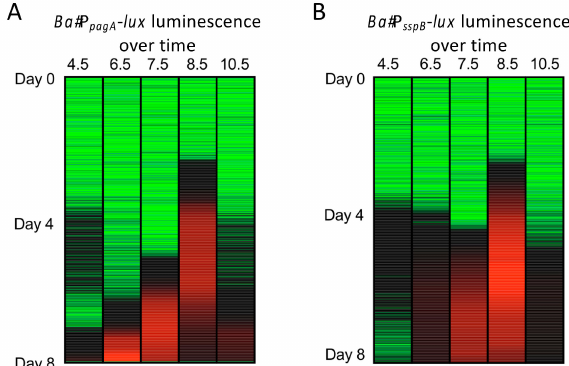
Figure 4. Induction of toxin elaboration and sporulation at di ff erent pH are tracked with luminescent reporter constructs. ( A ) Heat-map of luminescence production over time at di ff erent pH by P pagA - lux expressing B. anthracis when grown with shaking at 30 ◦ C in BHI broth. ( B ) Heat-map of luminescence production over time at di ff erent pH by P sspB - lux expressing B. anthracis Green = low expression, Red = high expression, black = mid-level expression.